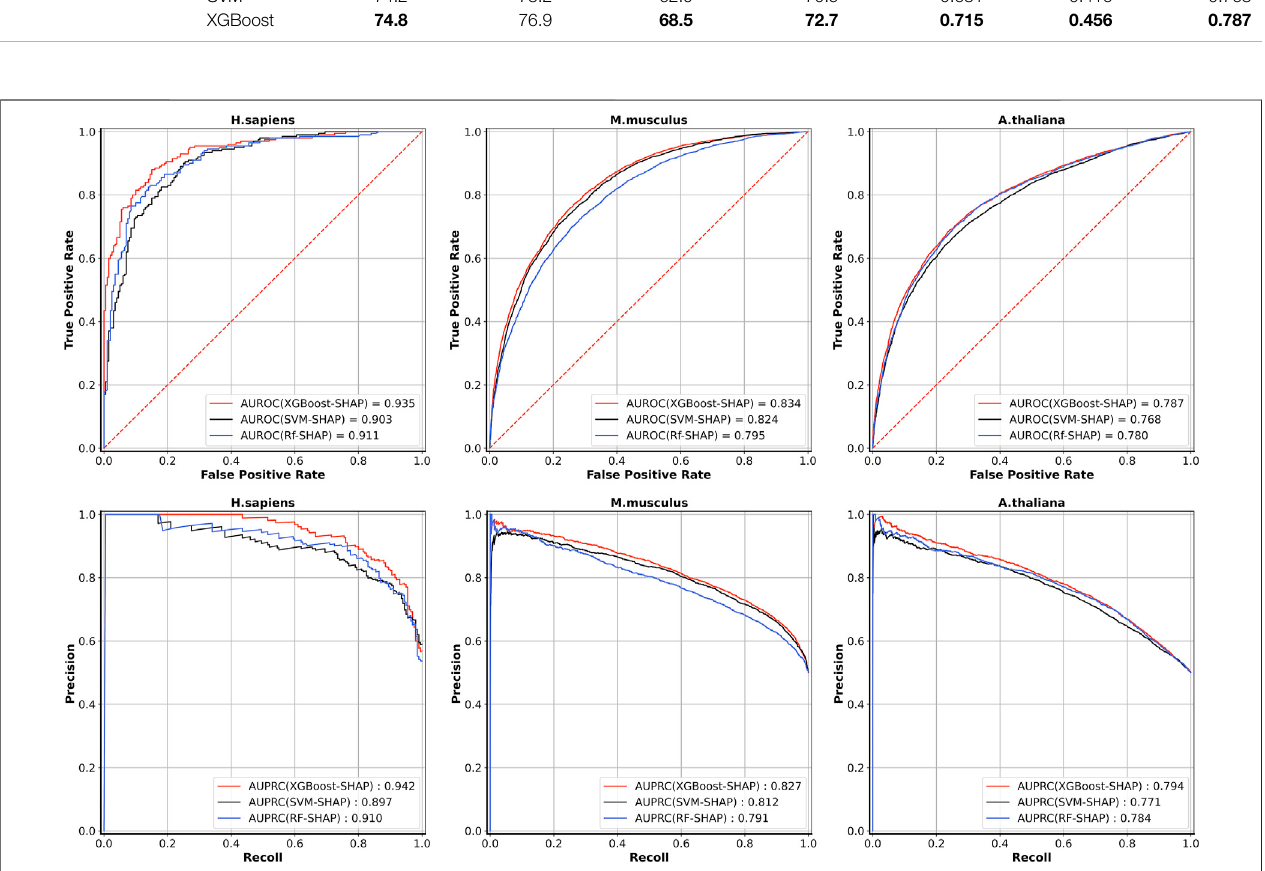
FIGURE 3 | The ROC curves and PRC curves of fi ve-fold cross-validation results based on three learning algorithms for the three species.